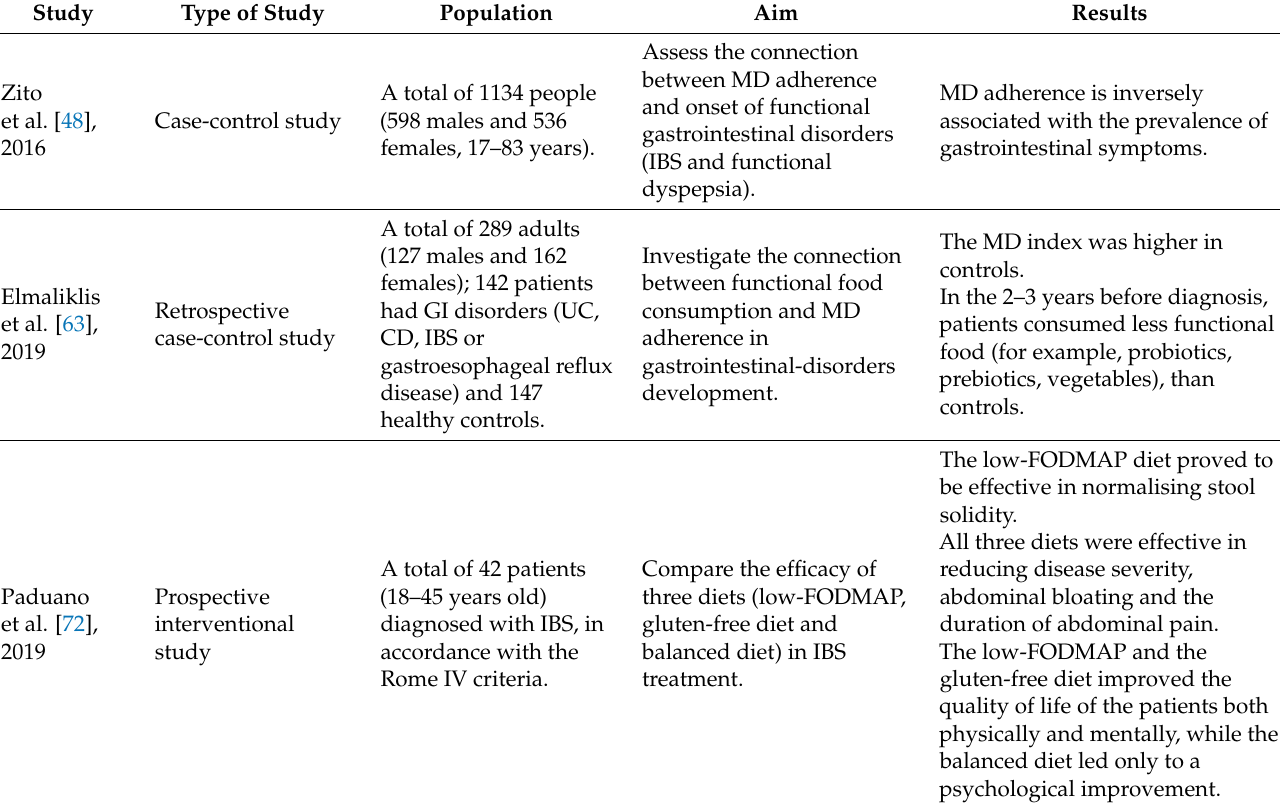
Table 2. Main characteristics of the studies regarding the impact of Mediterranean diet on